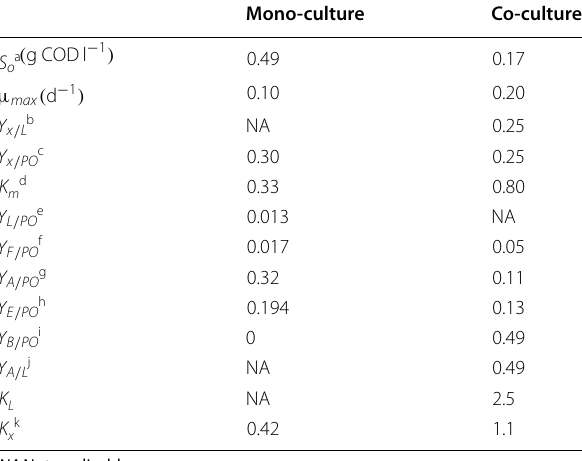
Table 3 Kinetic parameters obtained in MATLAB of C. ter- mitidis mono-cultured and co-cultured with C. beijerinckii on 2 g l − 1